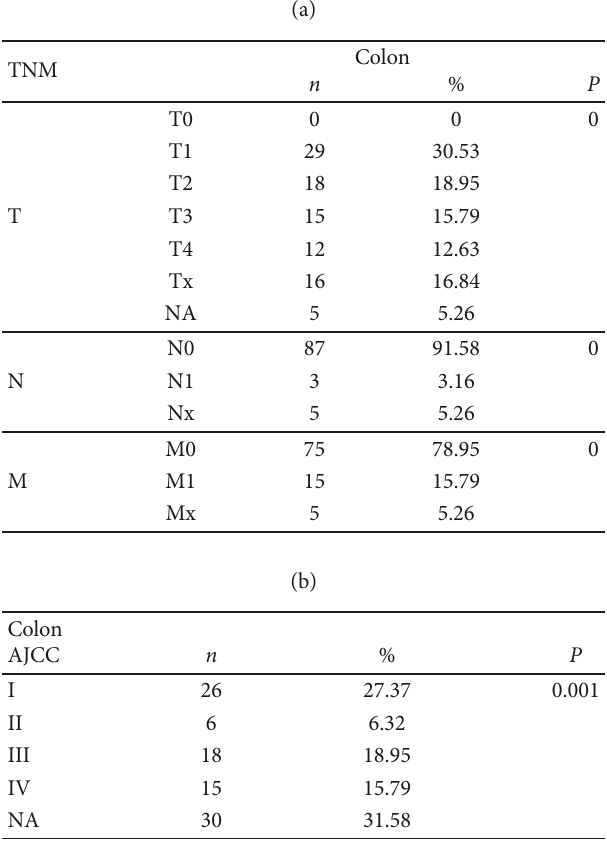
Table 2: TNM staging and AJCC staging for colonic GIST ( n = 95